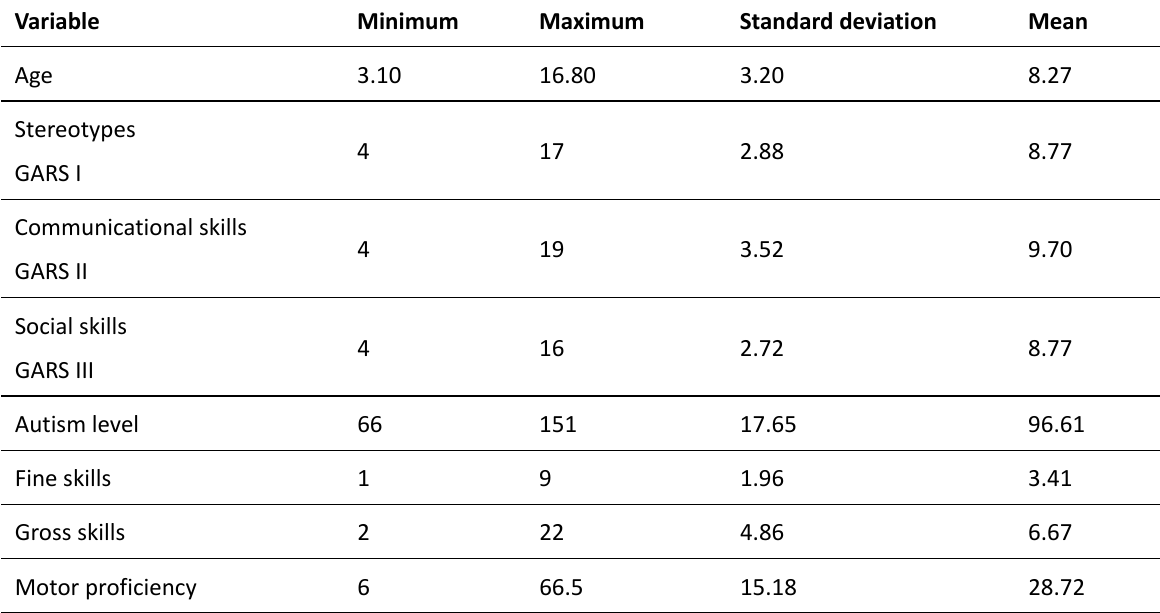
Table 1. Participants’ demography